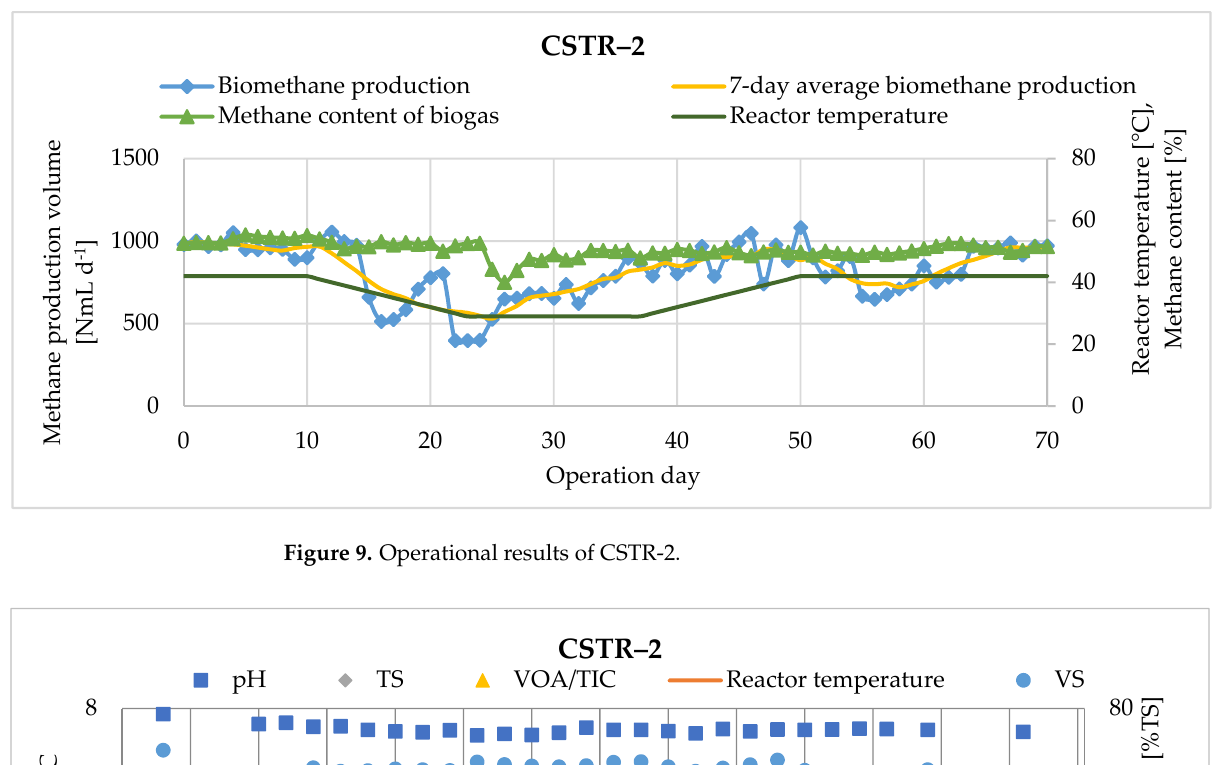
Figure 9. Operational results of CSTR-2.